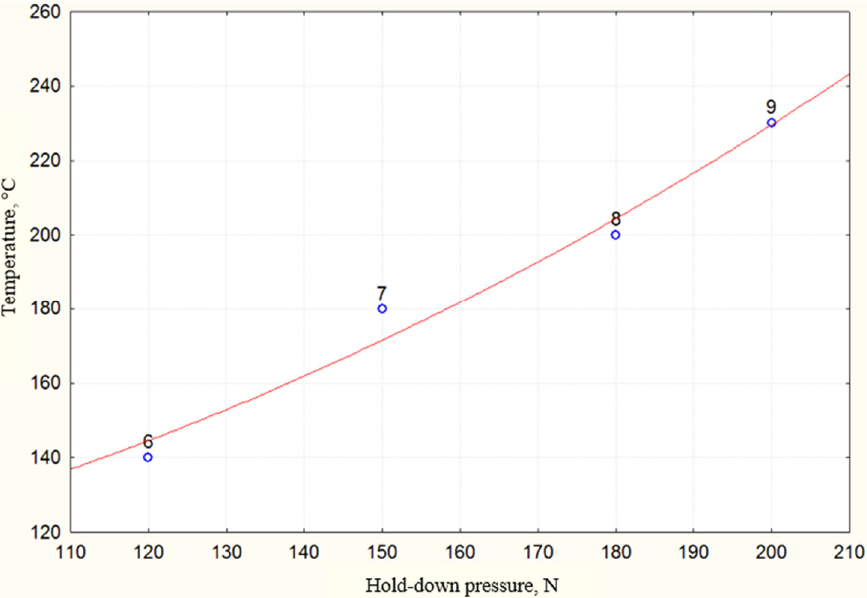
Figure 6. Dependence of the temperature in the burnishing zone on the clamping force of the tool during MQL burnishing.